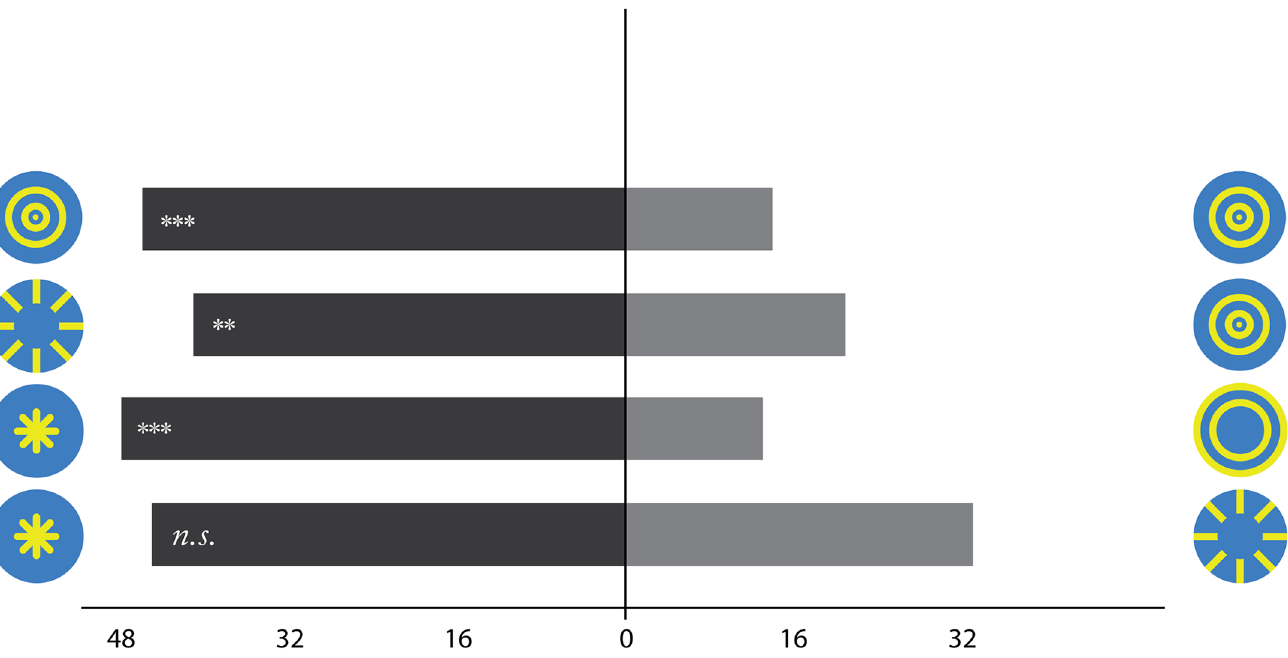
Fig 2. Behavioural pattern preferences: Pattern positioning versus pattern type. This bar graph shows the total number of choices made by bumblebee workers at each pattern combination. Whenever a radial pattern was pitted against a concentric one, bumblebee workers chose the radial pattern. In the last case where two radial patterns of different positioning were displayed, bumblebees showed no preference for either pattern. Adopted from Orbán & Plowright [37] Note : ** < .01, *** p < .001, n . s .: not significant. The figure shows test patterns in their original form, as used in the behavioural